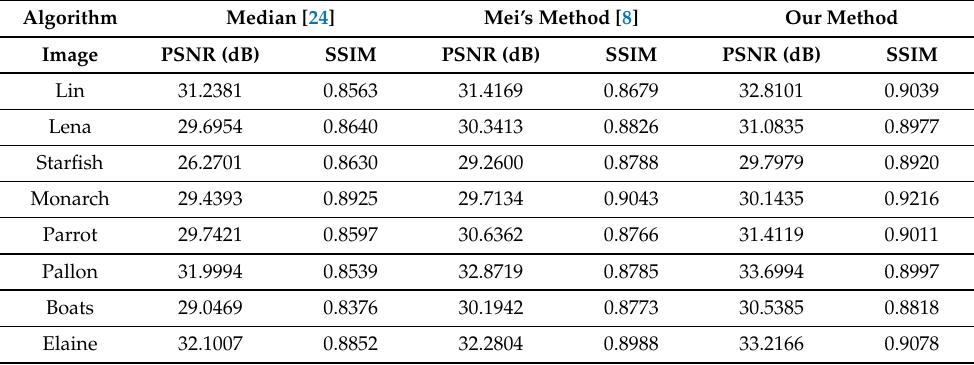
Table 2. PSNR and SSIM values for different algorithms ( η =